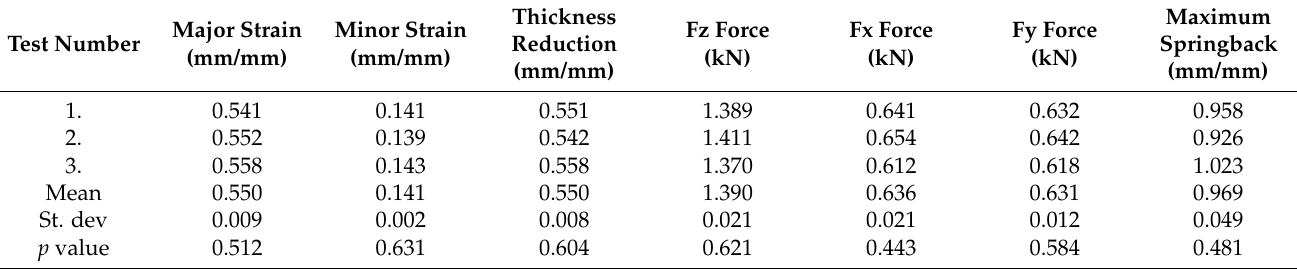
Table 9. Results for unwelded blanks processed by SPIF in truncated pyramid shape